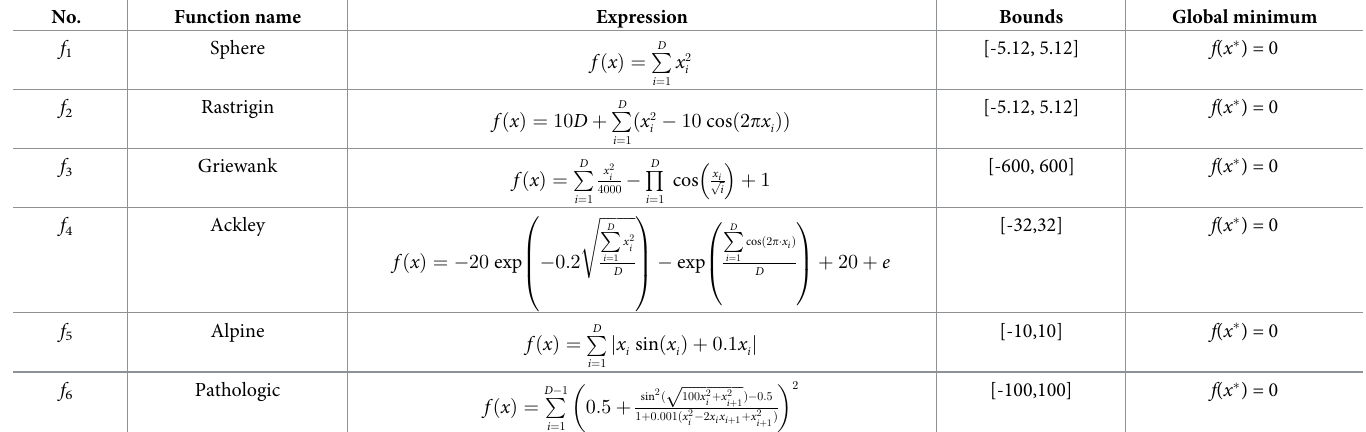
Table 1. Benchmark functions.